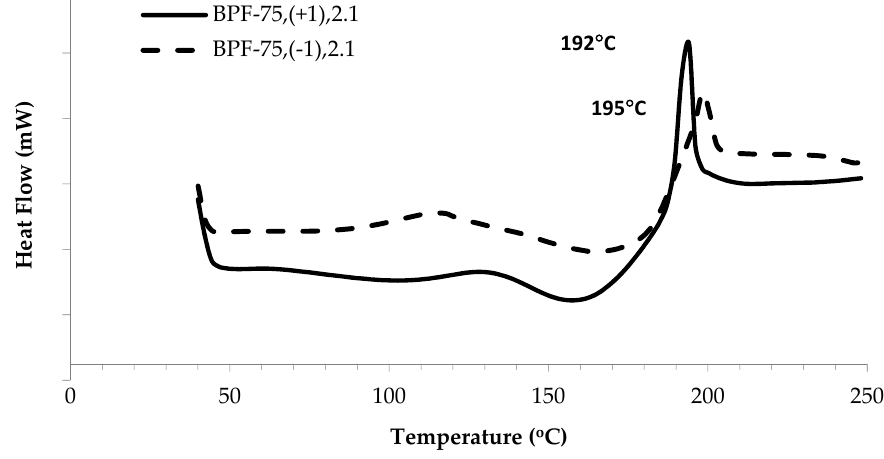
Figure 4. Effect of lignin molecular weight on curing temperature of BPF resins at 75% phenol substitution.